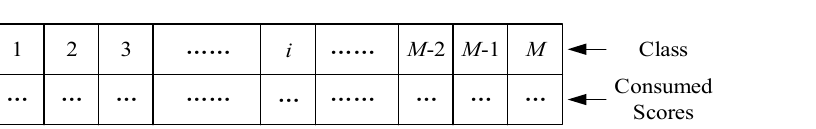
Figure 1 . Store Structure of Consumed Score for the M-Class Problem. Figure 1. Store Structure of Consumed Score for the M-Class